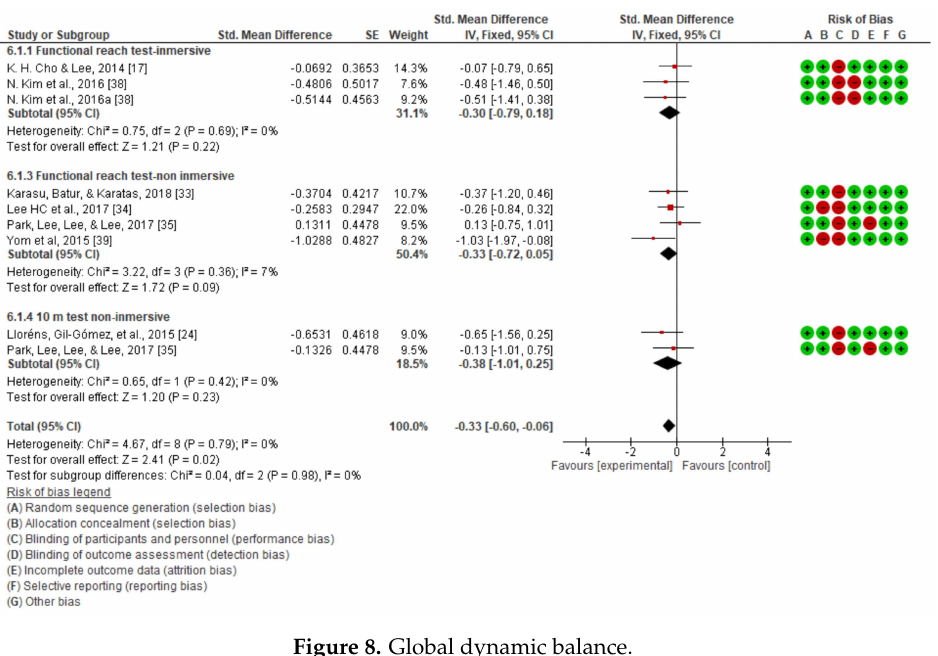
Figure 8. Global dynamic balance.